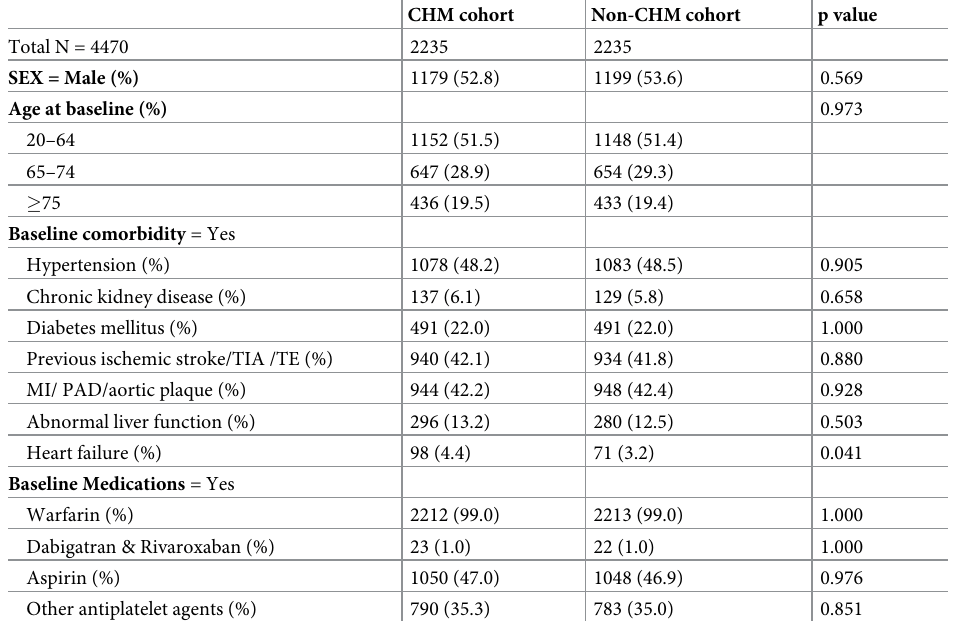
Table 1. Demographic characteristics, comorbidities and medications of patients using anticoagulants in Taiwan during 2000–2013. CHM cohort Non-CHM cohort p